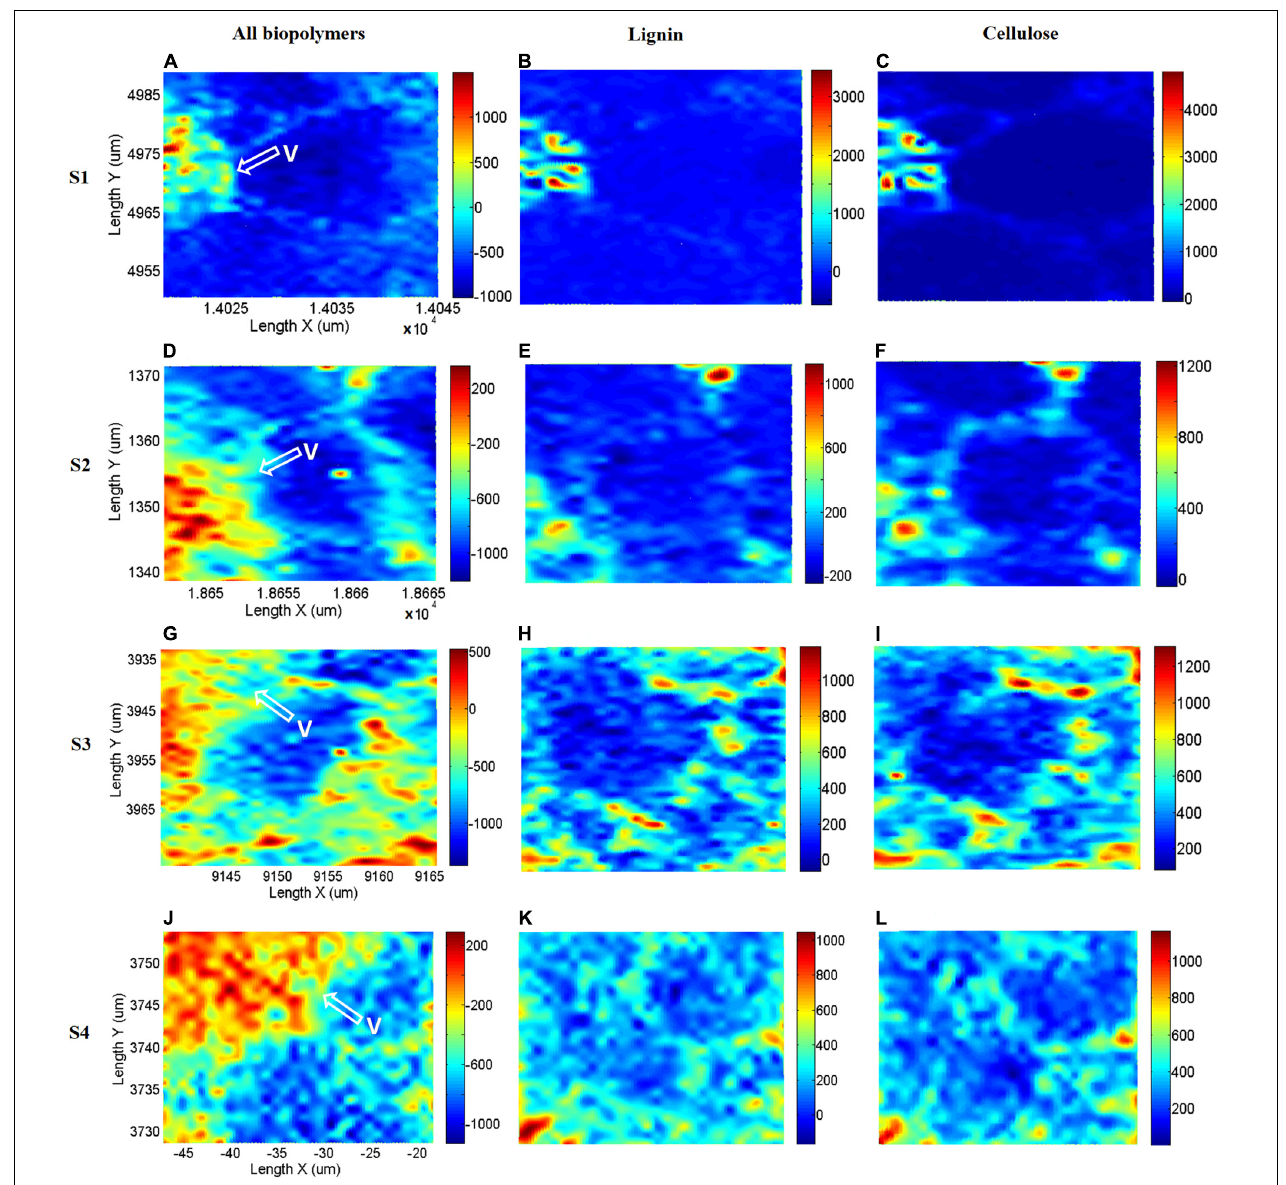
FIGURE 9 | Chemical images of four sections: S1 (A–C) , S2 (D–F) , S3 (G–I) , and S4 (J–L) . (A,D,G,J) : all polymers band intensity, (B,E,H,K) : lignin band intensity, and (C,F,I,L) : cellulose band